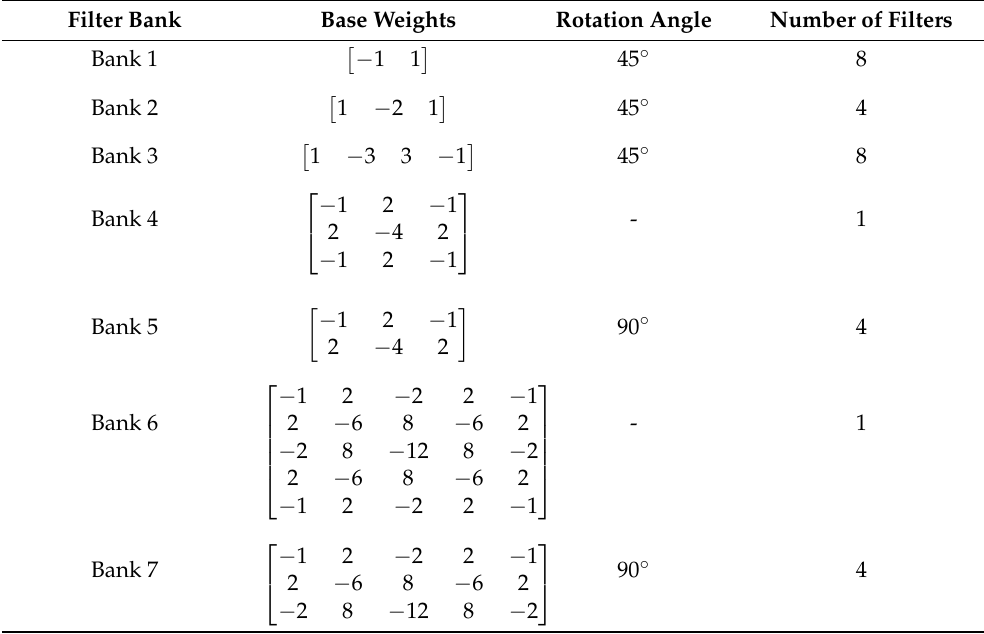
Table 1. Details of filter